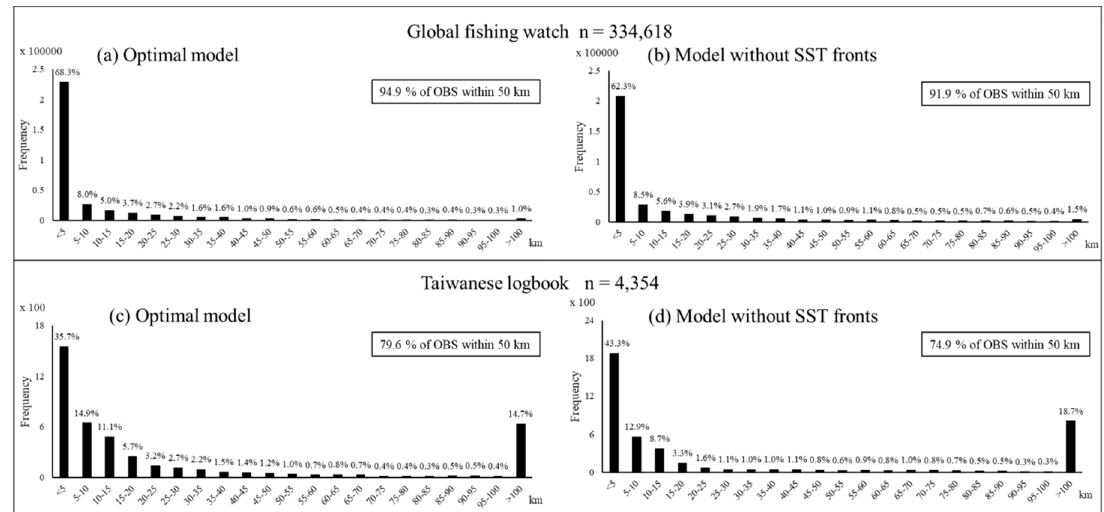
Figure 9. Histograms of the distances observed between fishing locations to the closet habitat boundary derived from ( a ) global datasets and ( c ) Taiwanese datasets in 2016; ( b ) global and ( d ) Taiwanese datasets in the model without SST fronts.